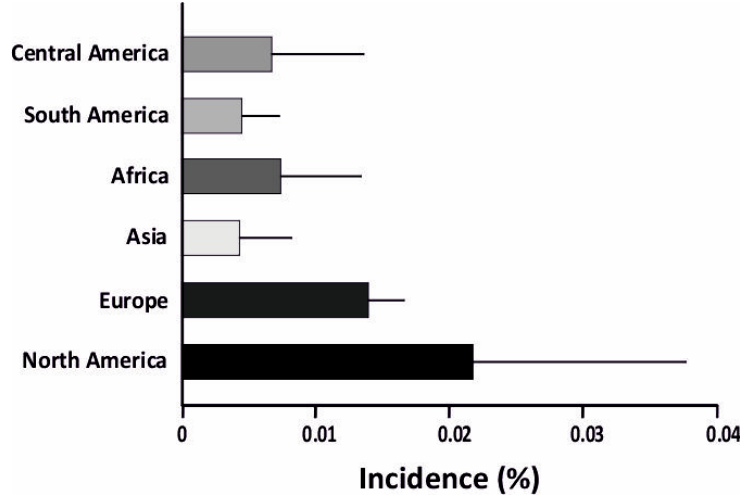
Figure 1. Incidence of T1D is higher in North America and Europe compared to other parts of the world. Notably, Asia has the lowest incidence of T1D. The incidence is plotted as a percentage, showing the incidence of T1D.